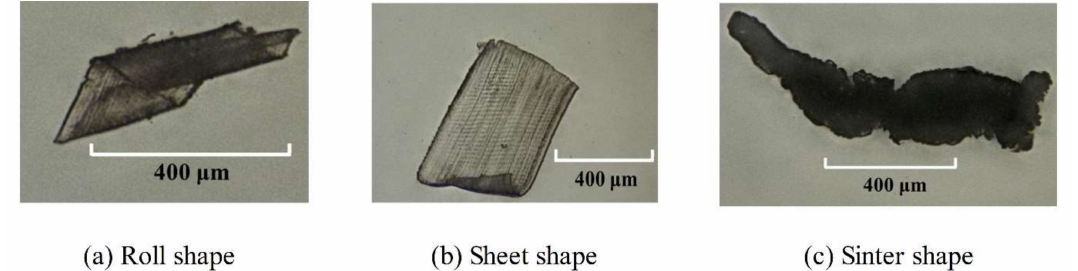
Figure 6. Cutting chips in di ff erent shapes: ( a ) roll shape; ( b ) sheet shape; ( c ) sinter shape. (The cutting chips were collected after the micromilling experiments with parameters in Table 1 and measured by the laser scan confocal microscope (VK-X250, Keyence Co., Osaka, Japan) with a 10 × microscope